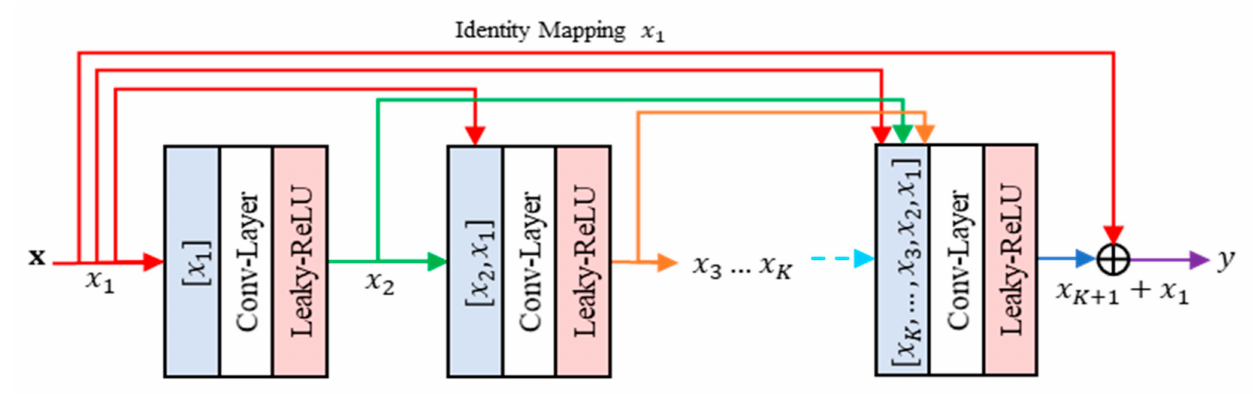
Figure 6. The architecture of residual concatenated networks